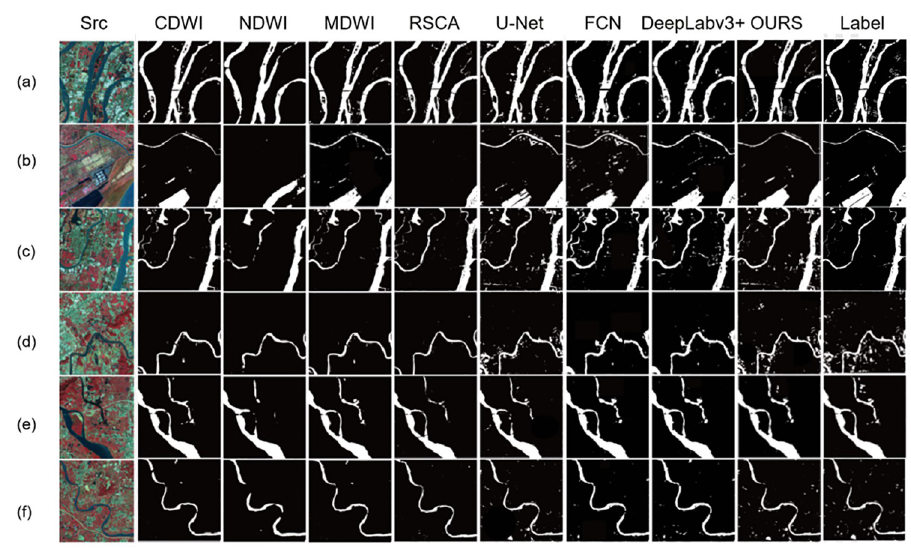
Fig 13. Comparison of water body extraction results of different